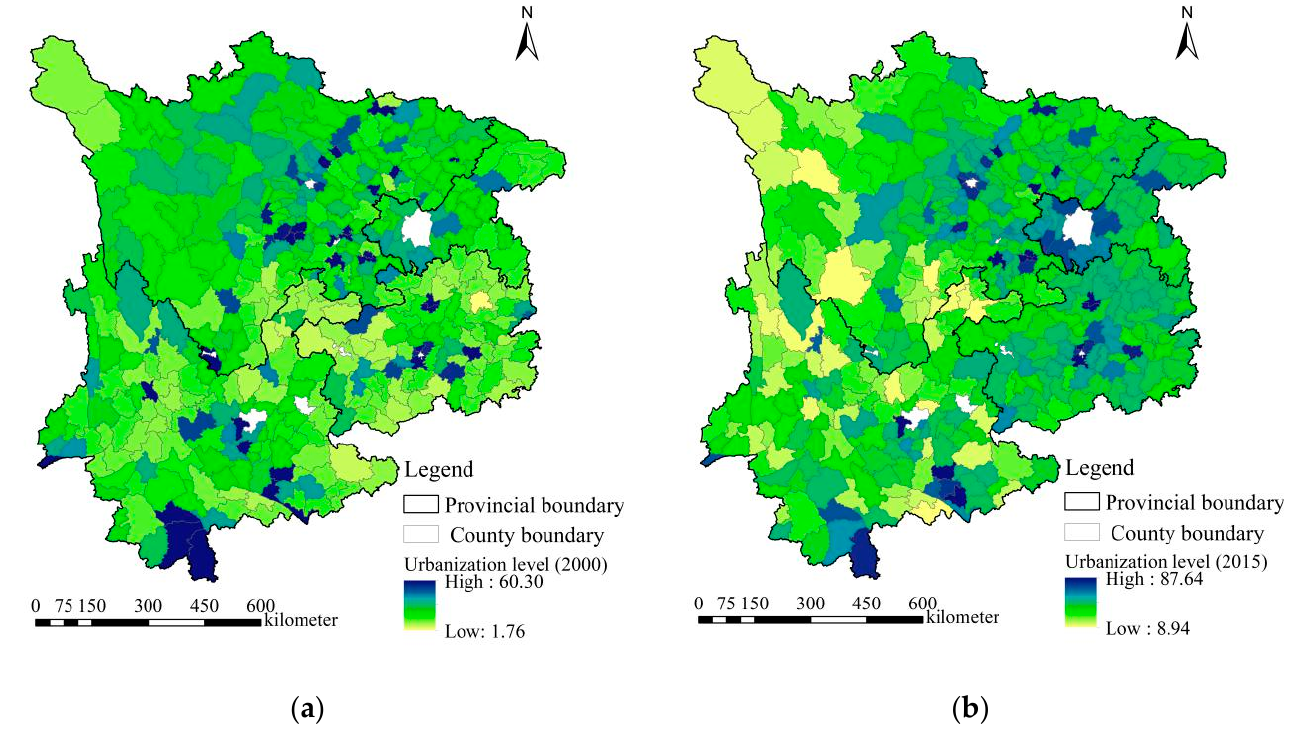
Figure 4. Spatial distribution of urbanization levels in the mountainous area of southwest China in ( a )2000 and ( b ) 2015.